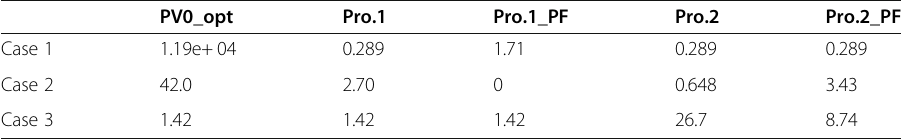
Table 8 Voltage violation amounts at all LV consumers (V ∙ min)